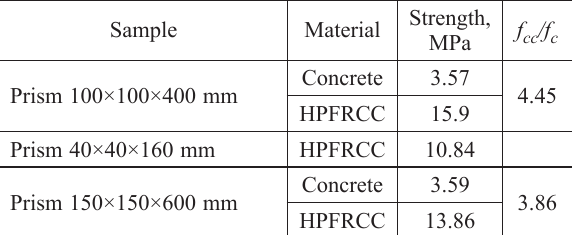
Table 2. Tensile strength of concrete and HPFRCC Sample